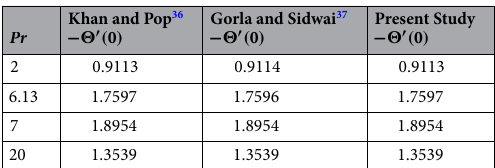
Table 2. Comparison result.